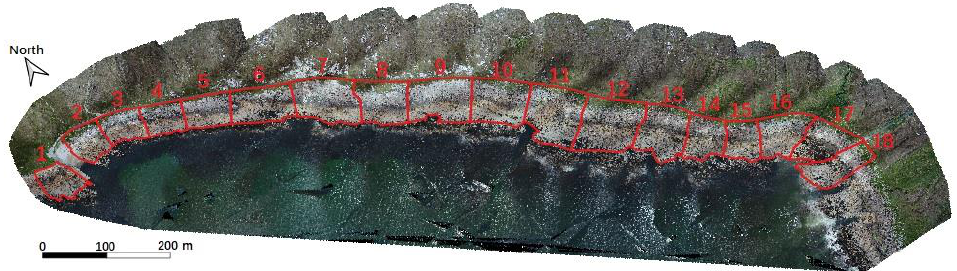
Figure 9. Sub-areas of the site used to improve point cloud alignment and computational efficiency.